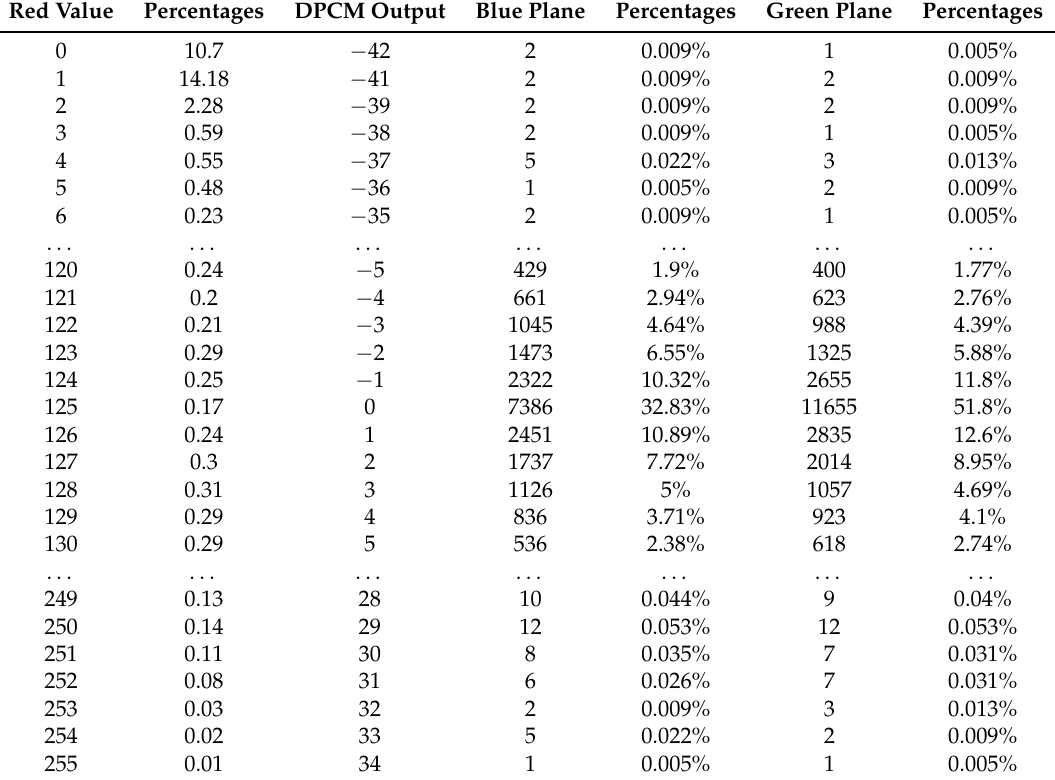
Table 1. Table shows a few components of and their time of occurrences of Blue and Green plane after DPCM code is